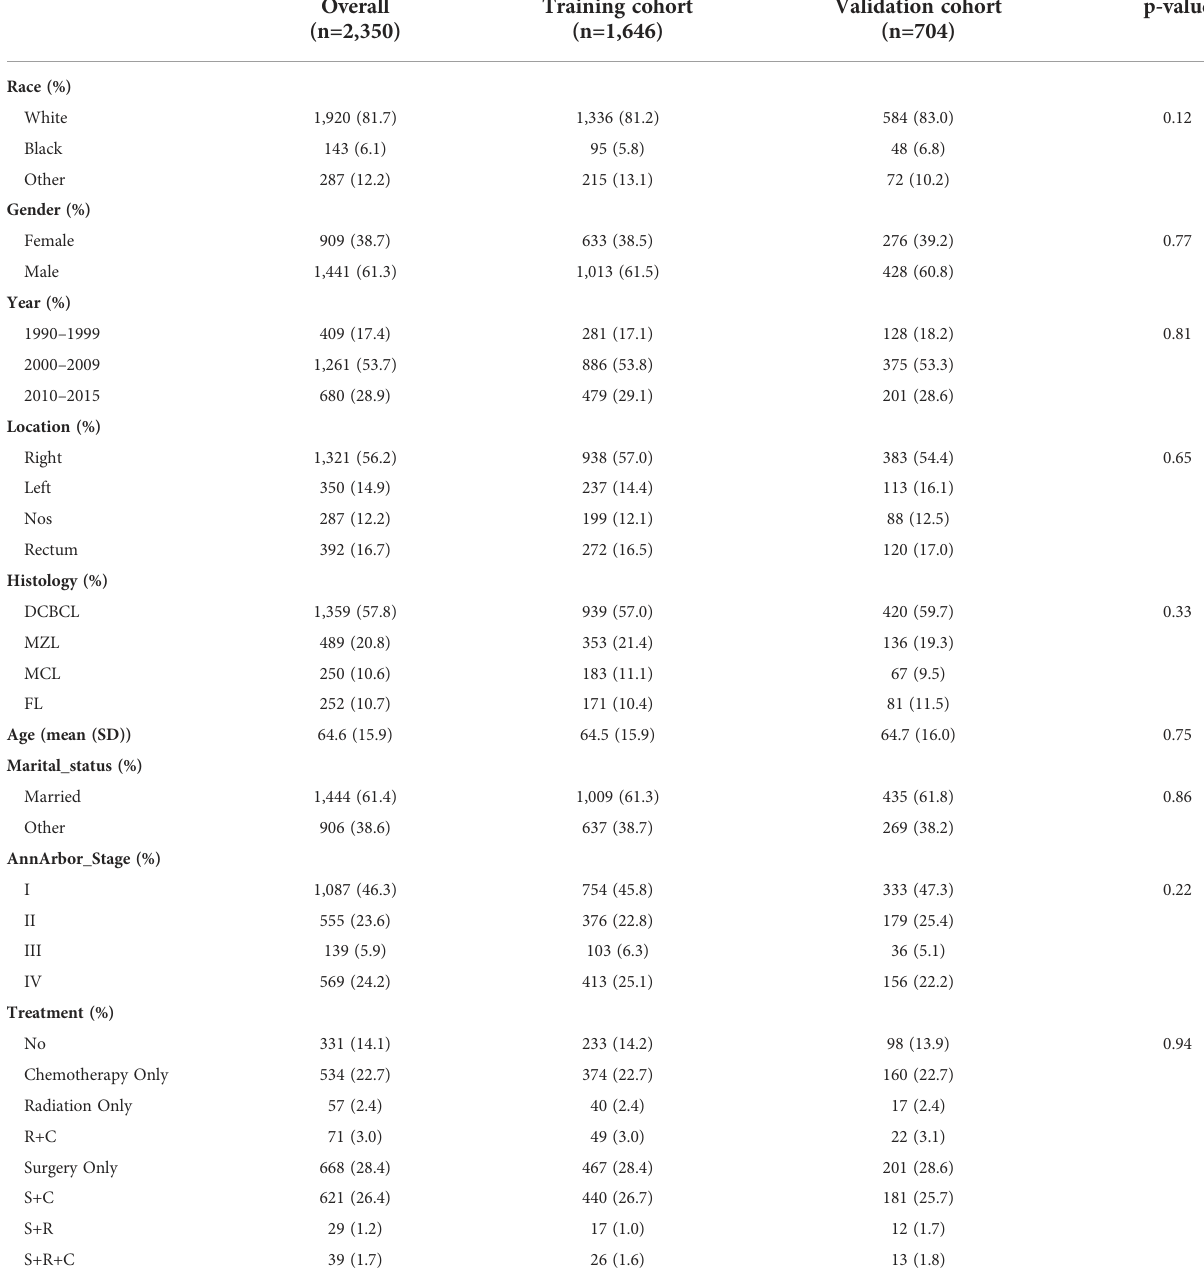
TABLE 1 Baseline demographic and clinical characteristics of PCL